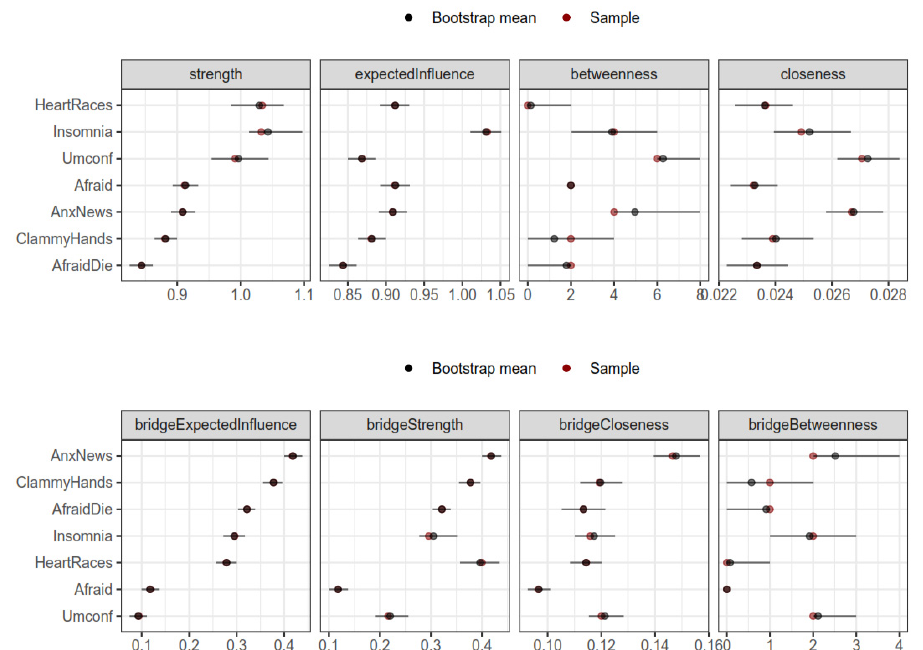
Figure 3. Centrality and bridge centrality indices for all items. Note: Horizontal axis represents scores in each bridge centrality index. Shaded regions represent 95% confidence intervals for the measures.